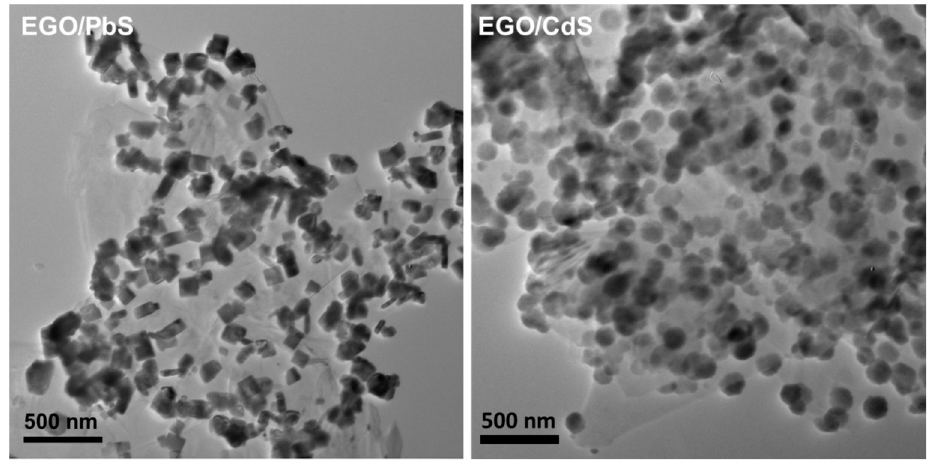
Figure 8. Transmission electron microscopy (TEM) images of exfoliated graphite oxide (EGO) decorated with PbS and CdS nanocrystals.